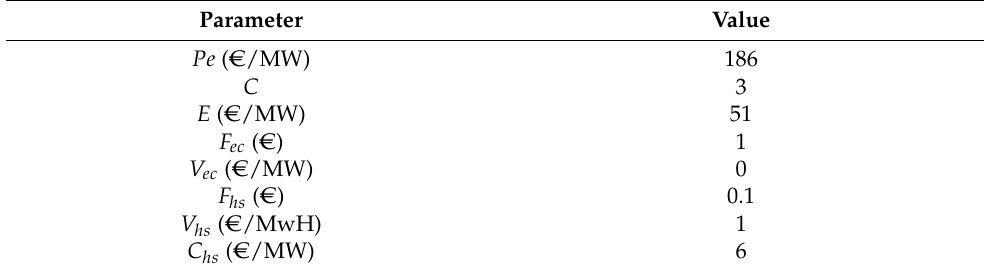
Table 1. Parameters for the Brunswick